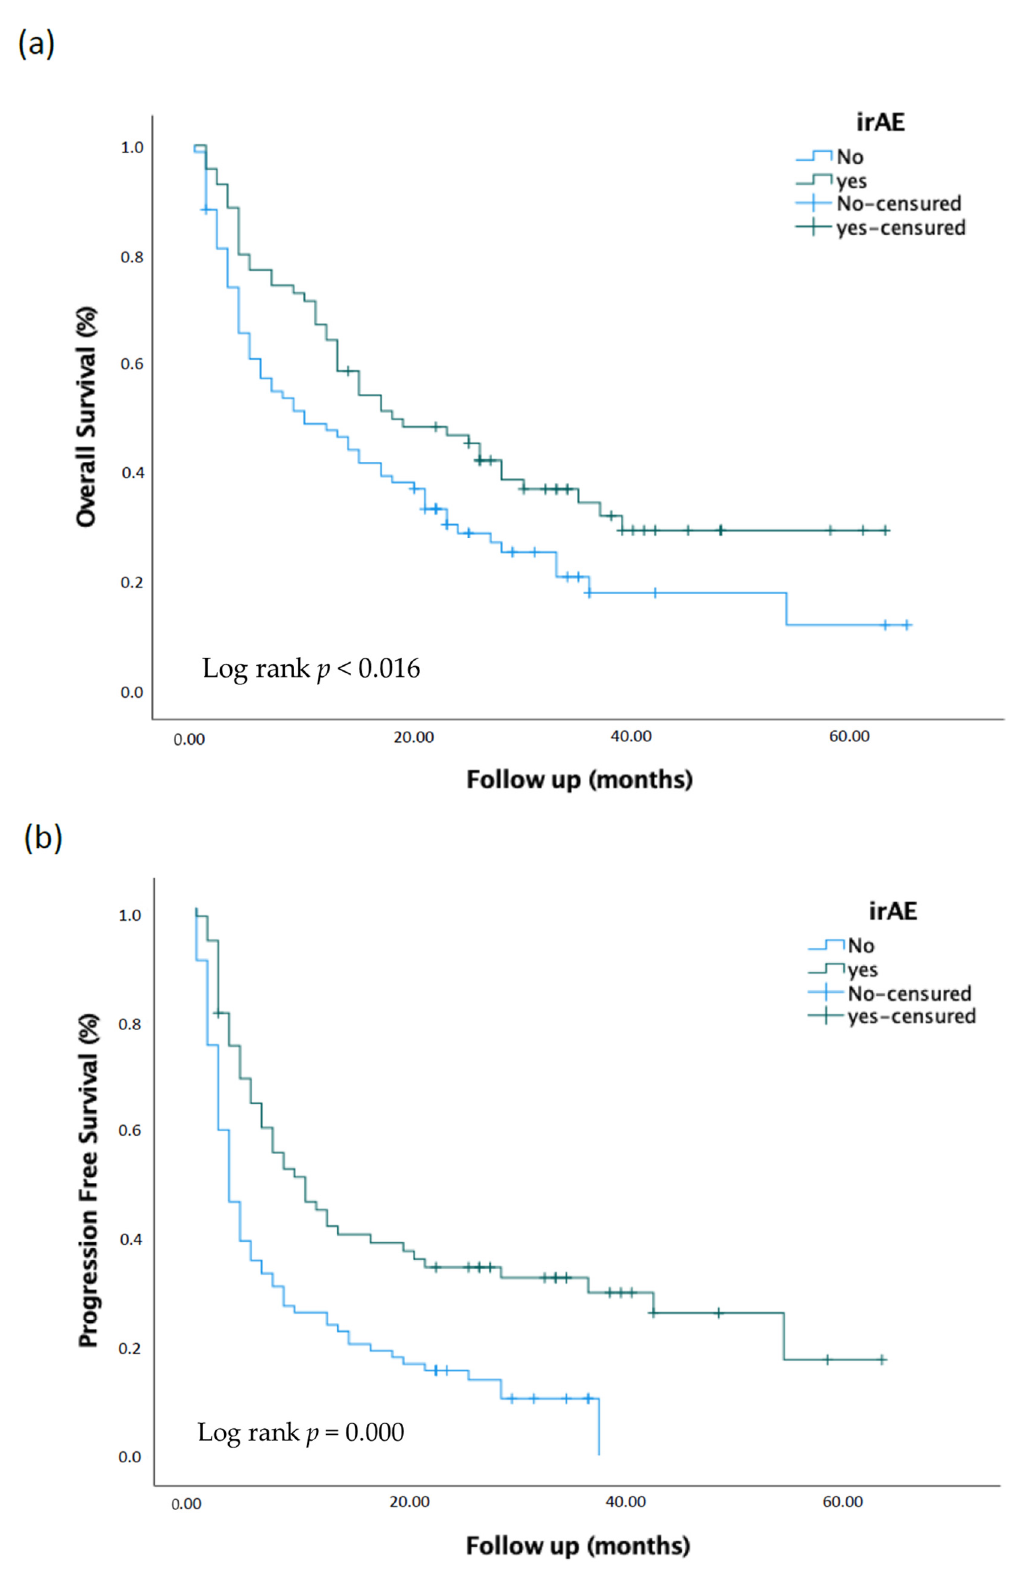
Figure 1. Kaplan–Meier analysis of overall survival ( a ) and progression free survival ( b ) comparing patients irAE and non-irAE. Table 3. Univariate and Multivariate cox proportional hazards regression analysis of the risk of death.